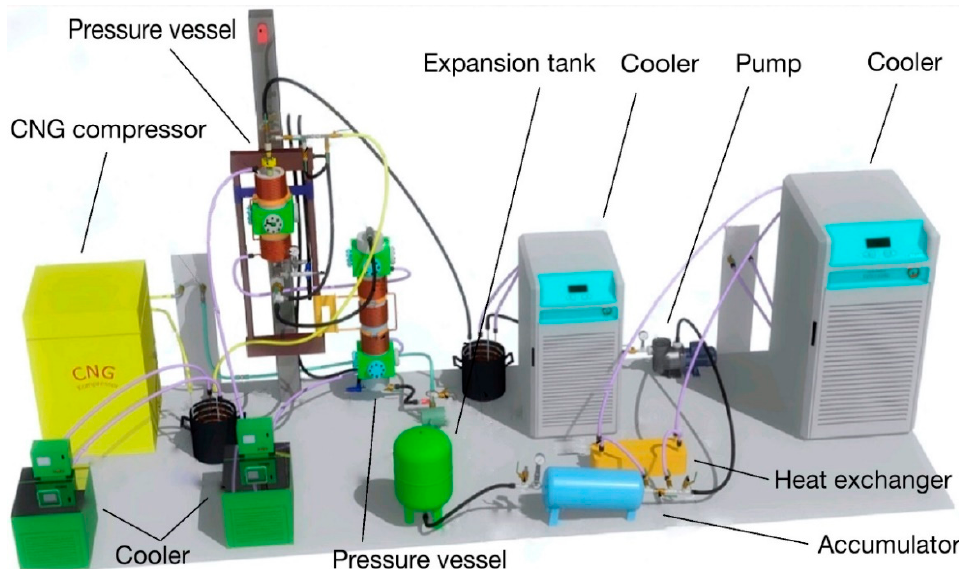
Figure 2. 3-D model of experimental device.